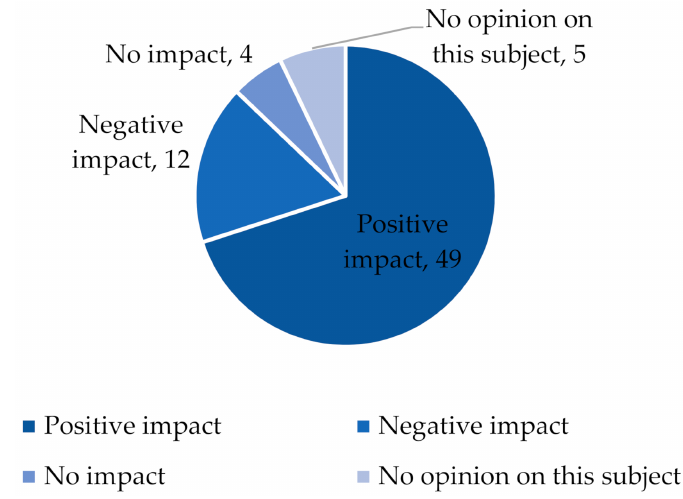
Figure 1. The impact of the Fourth Industrial Revolution on business models.